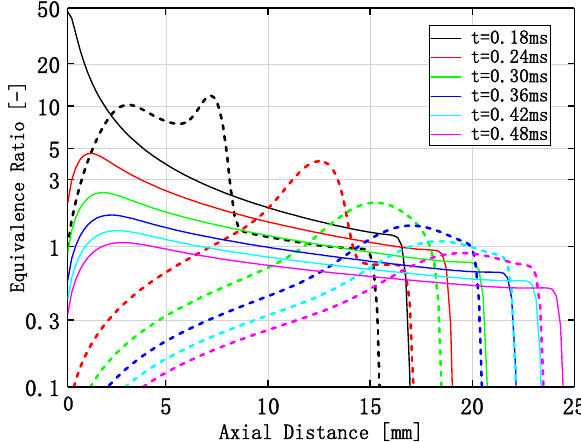
Figure 11. Comparisons of equivalence ratio between the ramping-down single injection and the multiple-injection (solid lines: ramping-down single injection; dotted lines: multiple-injection).